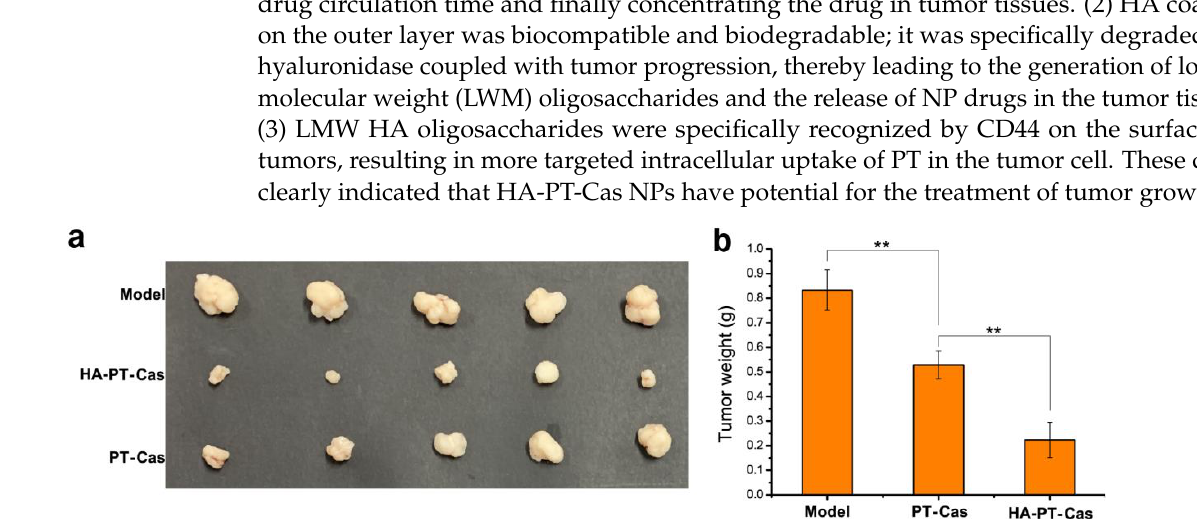
Figure 5. The antitumor activity of animal experiments with different PT nanoparticles treat- ments . ( a ) Changes in tumor volumes in model groups, and HA-PT-Cas NPs and PT-Cas NPs groups after the final drug treatments. ( b ) Tumor weight changes. ** indicate statistical difference of the values at p < 0.01.